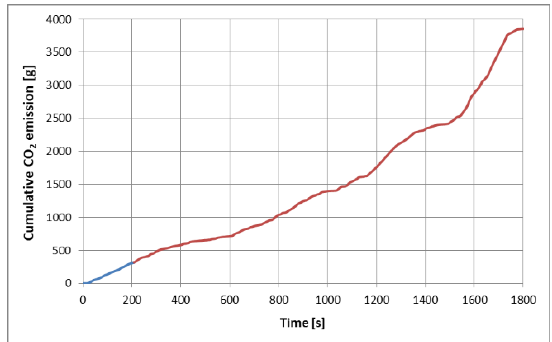
Figure 5: Cumulative value of CO 2 emission in WLTC cycle for temper- ature 10 ∘